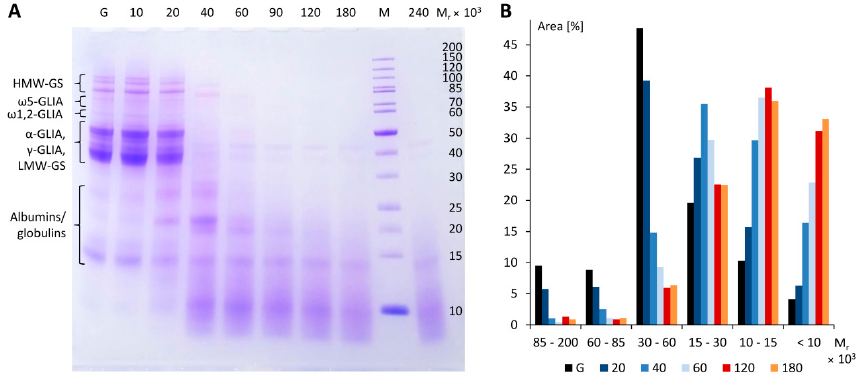
Figure 1. Sodium dodecyl sulfate-polyacrylamide gel electrophoresis (SDS-PAGE) of gluten (G) and different peptic digests incubated at 37 ◦ C for 10 min, 20 min, 40 min, 60 min, 90 min, 120 min, 180 min and 240 min at an E:G:S ratio of 1:25:100 ( A ). Area (%) relative to the total area of selected bands according to molecular weight ranges of marker M ( B ). HMW-GS, high-molecular-weight glutenin subunits, LMW-GS, low-molecular-weight glutenin subunits, M, molecular weight marker, M r , relative molecular weight, α -GLIA, α -gliadins, γ -GLIA, γ -gliadins, ω 5-GLIA, ω 5-gliadins, ω 1,2-GLIA, ω